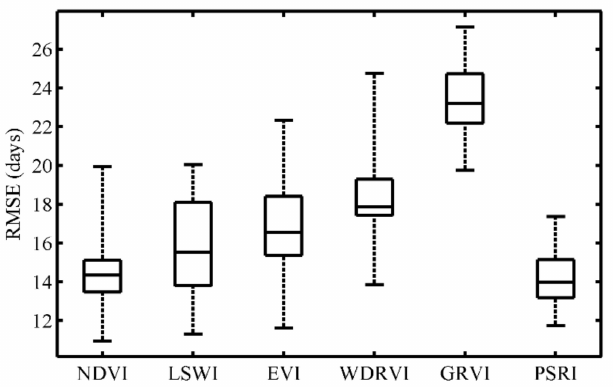
Figure 3. Medians and ranges of root mean square error (RMSE) between the growing season end dates retrieved from di ff erent vegetation indices and leaf fall end dates from 2000 to